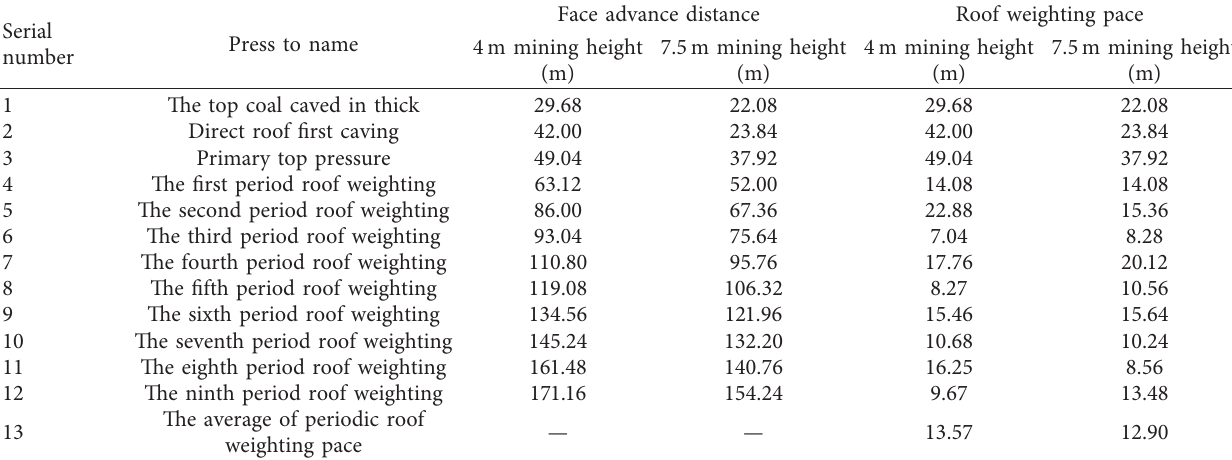
Table 1: The statistics of top coal, immediate roof, and basic roof caving